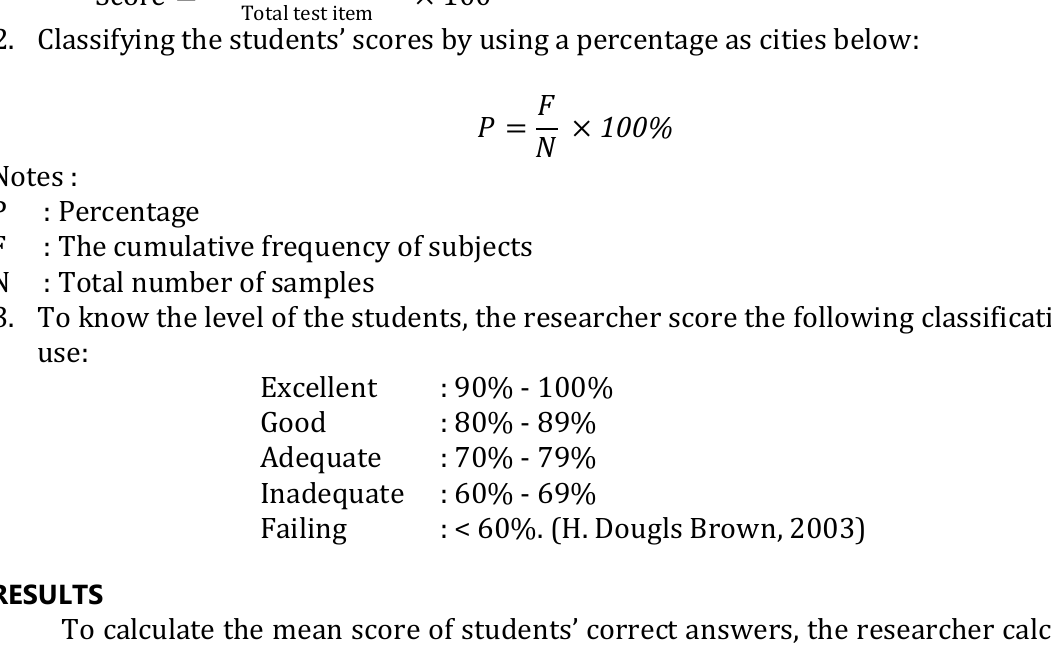
Table 1. The Mean Score of Students’ Correct Answer in Pre –